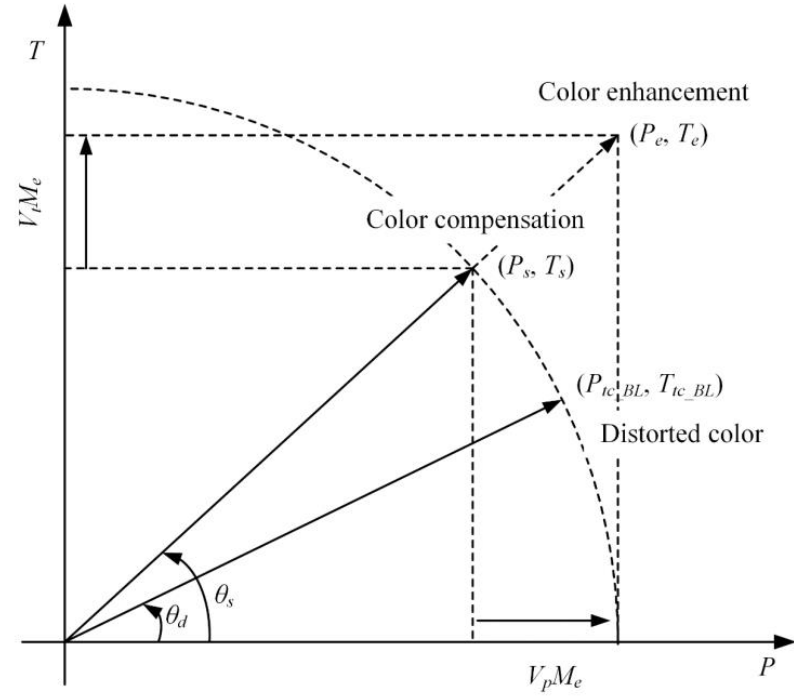
Figure 5. Proposed color compensation and enhancement.